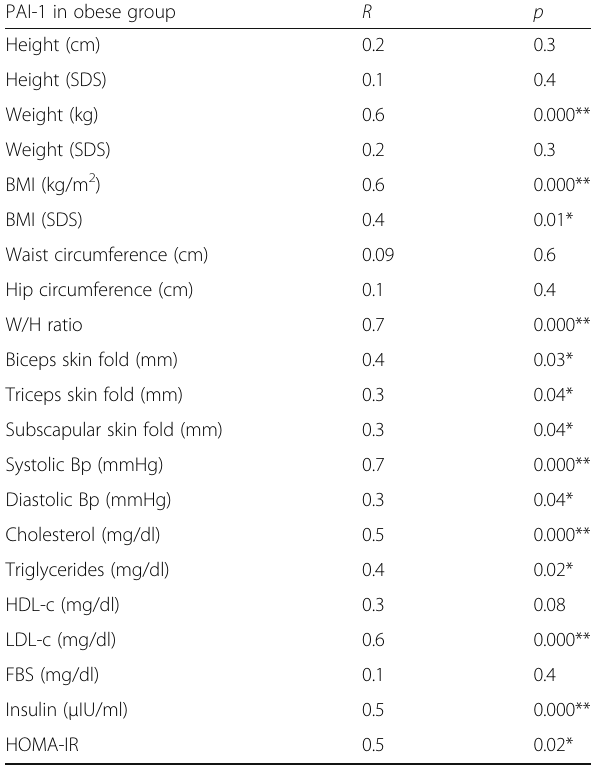
Table 2 Correlation between PAI-1 and the anthropometric measures and blood pressure measurements and the